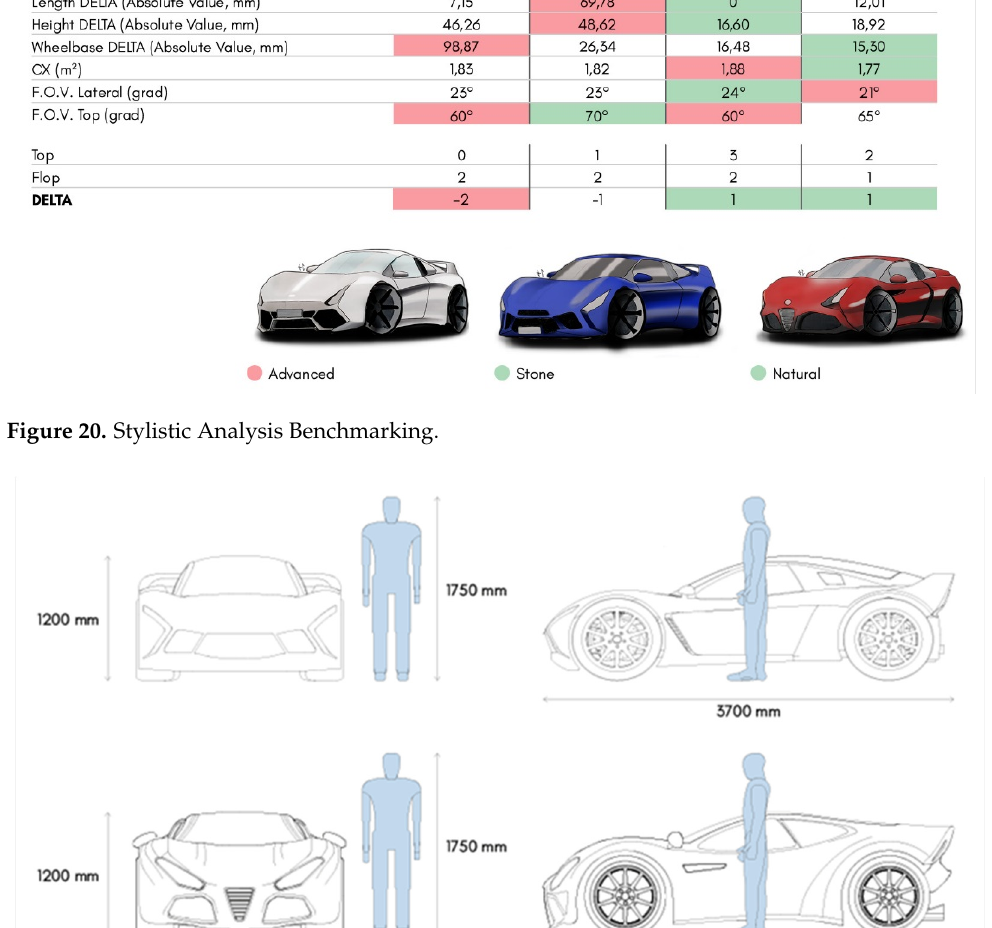
15 of 28 Figure 19. Simulation and measuring of visibility angles for each concept.